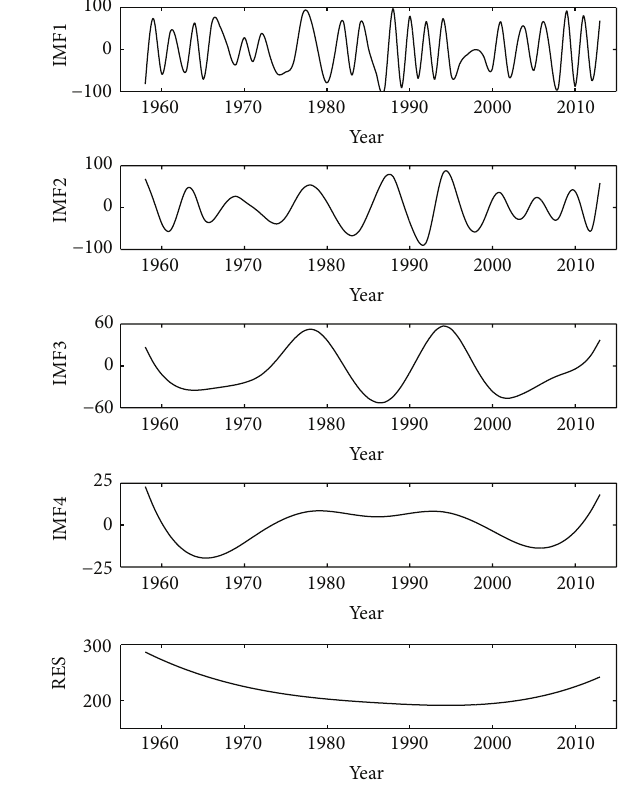
Figure 5: EEMD of the 𝑃 mf time series from 1958 to 2013 at the Suide